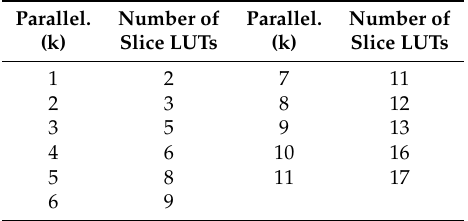
Table 5. Number of Zynq 7000 xc7z010clg400-1 FPGA-slice lookup tables (LUTs) for different k values.